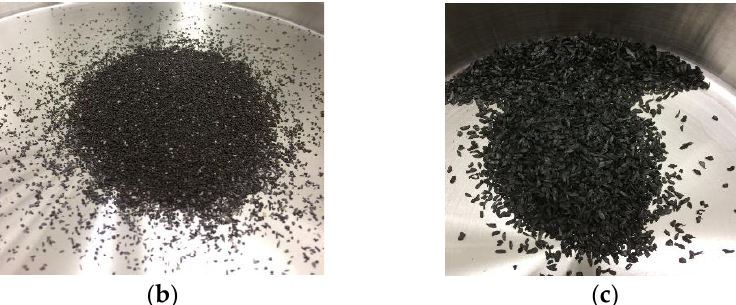
Figure 1. Pictorial description of the samples of the DBD reactor bed materials that are commonly used for generic applications. ( a ) Quartz sand ( b ); olivine ( c ); char.